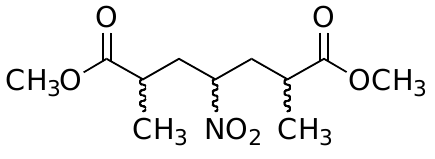
Figure 3. Double 1,4-addition product, compound 9